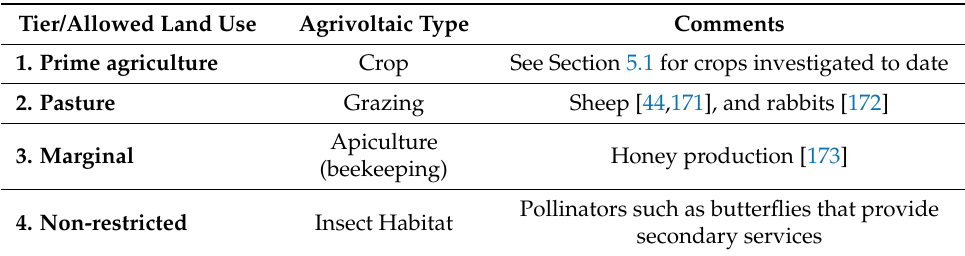
Table 1. Proposed potential tiers of agrivoltaic systems to favor systems with greater land-use efficiency and greater potential for GHG emissions